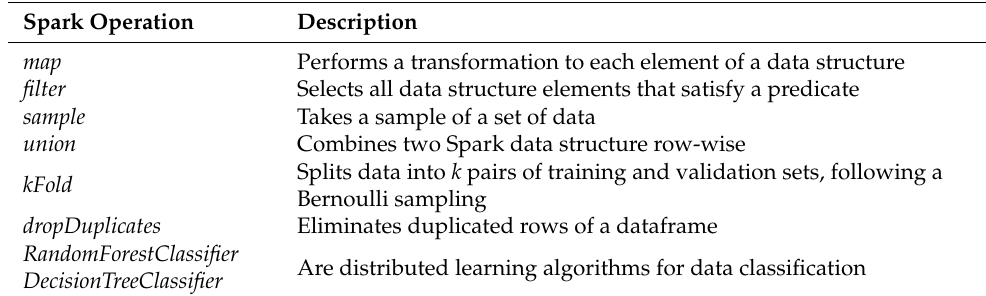
Table 1. Spark primitives and utilities used in FDR 2